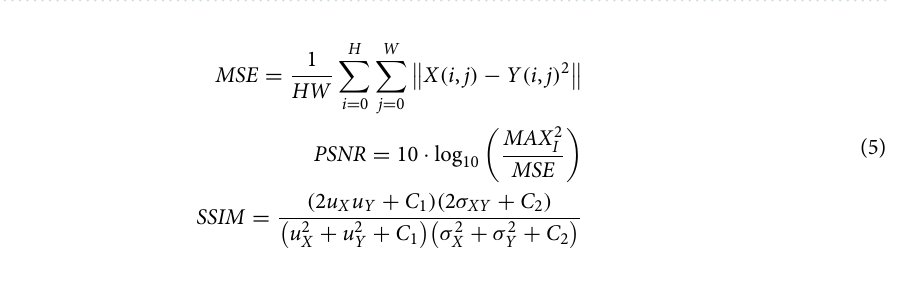
Figure 5. The two line chart of PSNR and SSIM are changed with the training. The reference image is a randomly selected image in the data set, which can basically reflect the changes of the image in the training process.